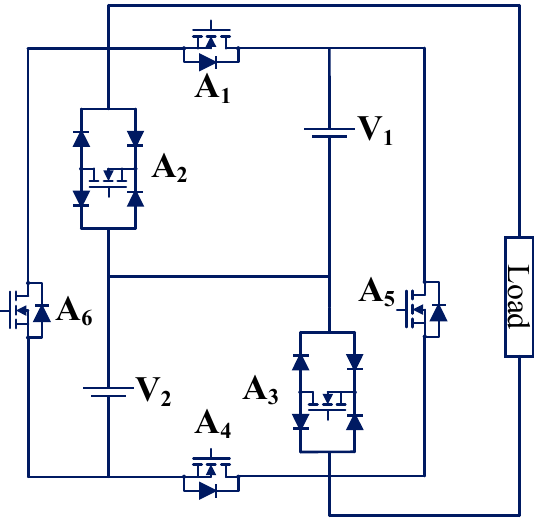
Figure 24. Single-phase five-level FT MLI (TP26)